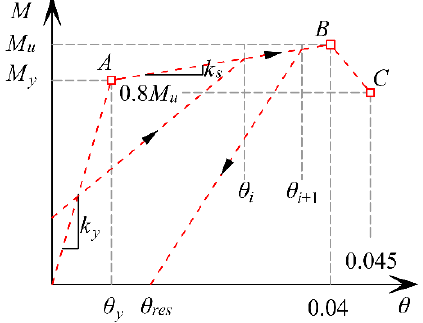
Figure 9. Calculation model of PCH joints.